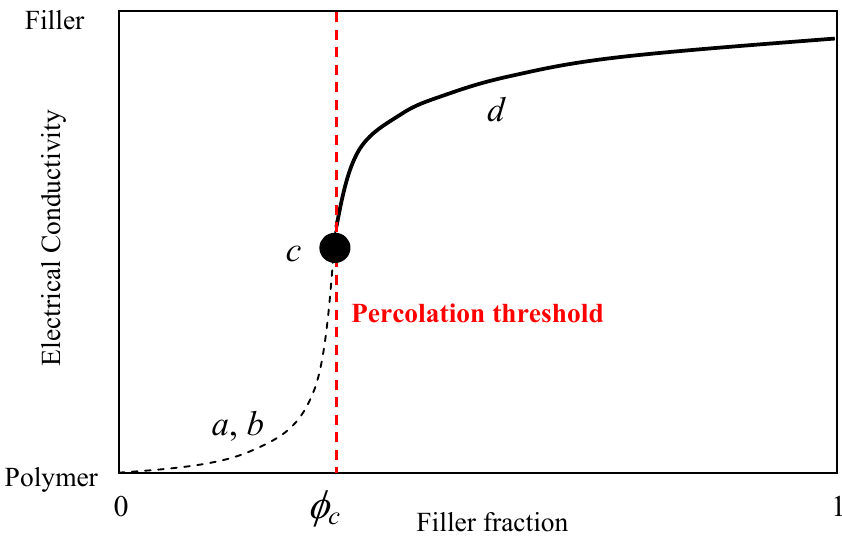
Figure 2. Electrical conductivity of conductive composites as a function of filler fraction, where “ a , b , c , d ” denote the different states in Figure